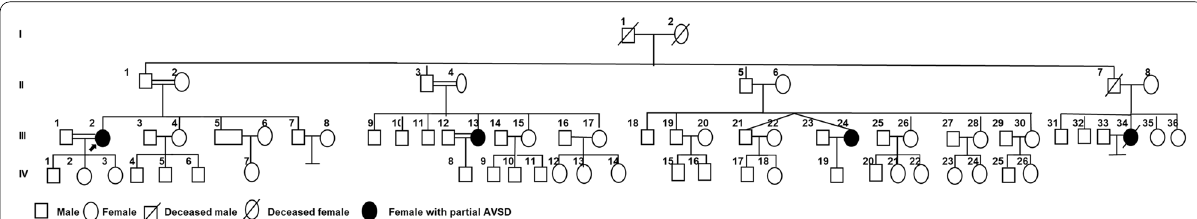
Fig. 1 Pedigree of the kindreds indicating the confirmed cases of partial AVSD or primum type